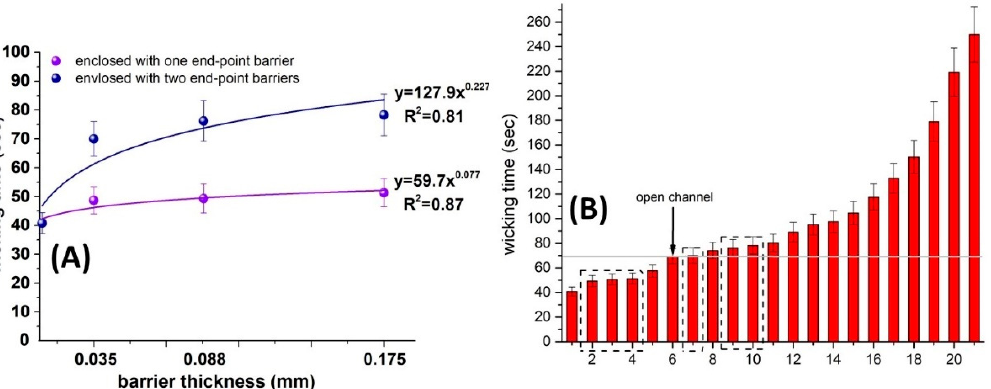
Figure 5. ( A ) Graph of wicking time as a function of linear line barrier width at the end of fluid flow enclosed between two hydrophobic layers. ( B ) Wicking times obtained by combining fluidic delays and accelerators (combined designs indicated by a dashed box) as compared to fluid delays and accelerators (without dashed box). 1 : two overlaying layers, 2 : two overlaying layers with one end barrier of 0.035 mm width, 3 : two overlaying layers with one end barrier of 0.088 mm width, 4 : two overlaying layers with one end barrier of 0.175 mm width, 5 : one overlaying layer, 6 : regular (open) channel, 7 : two overlaying layers with two end barriers of 0.035 mm width, 8 : one end barrier of 0.035 mm width, 9 : two overlaying layers with two end barriers of 0.088 mm width, 10 : two overlaying layers with two end barriers of 0.175 mm width, 11 : two end barriers of 0.035 mm width, 12 : one end barrier of 0.088 mm width, 13 : one end barrier of 0.175 mm width, 14 : one start barrier of 0.035 mm width, 15 : two end barriers of 0.088 mm width, 16 : two end barriers of 0.175 mm width, 17 : two start barriers of 0.035 mm width, 18 : one start barrier of 0.088 mm width, 19 : two start barriers of 0.088 mm width, 20 : one end barrier of 0.088 mm width, 21 : two start barriers of 0.175 mm width.